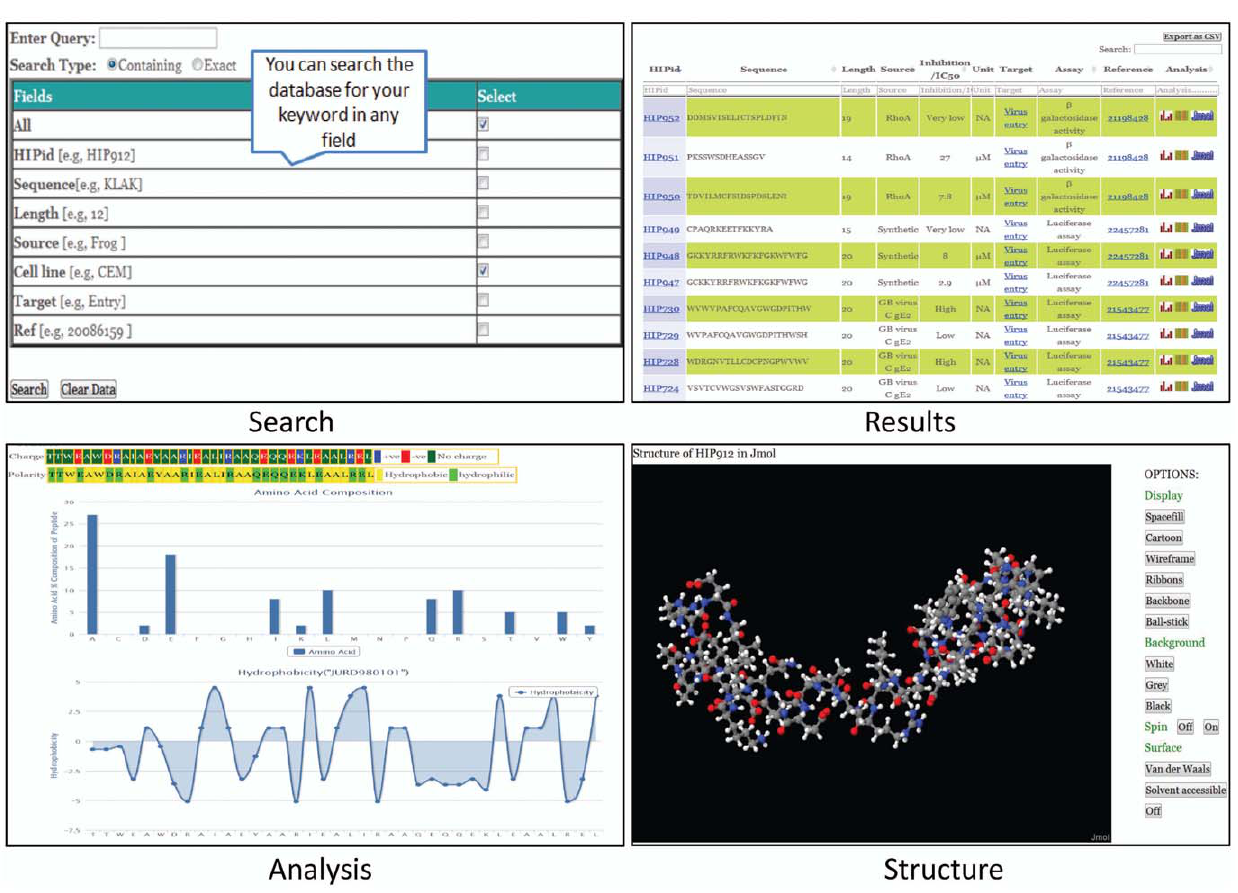
Figure 1. User interfaces in HIPdb.